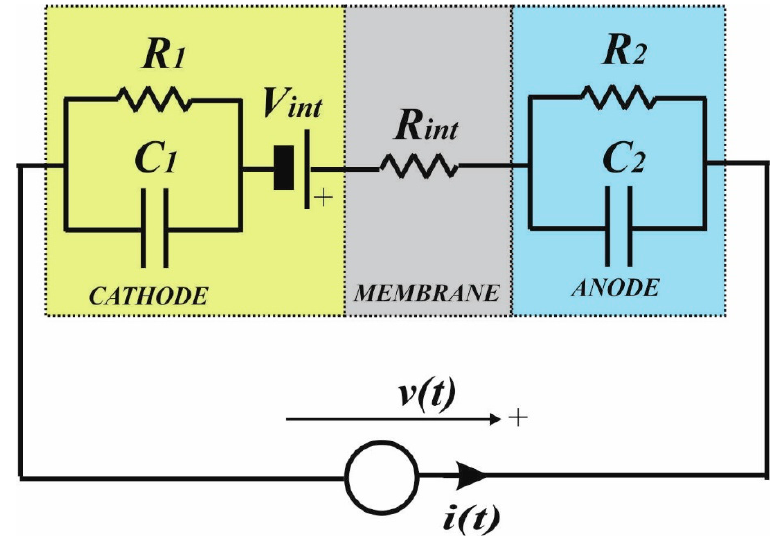
Figure 2. Equivalent electric scheme of the PEM electrolyzer (EL).